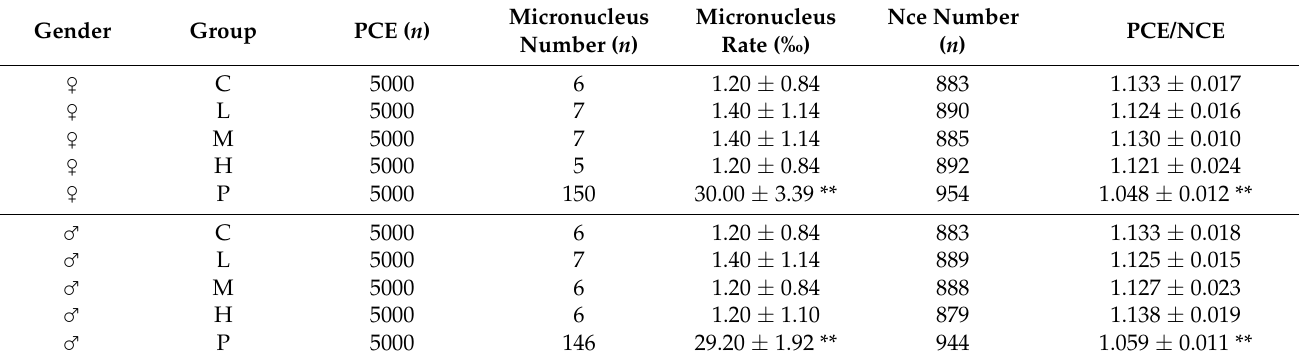
Table 1. Effect of enzyme solution on micronucleus rate of bone marrow cells in mice ( n = 5).